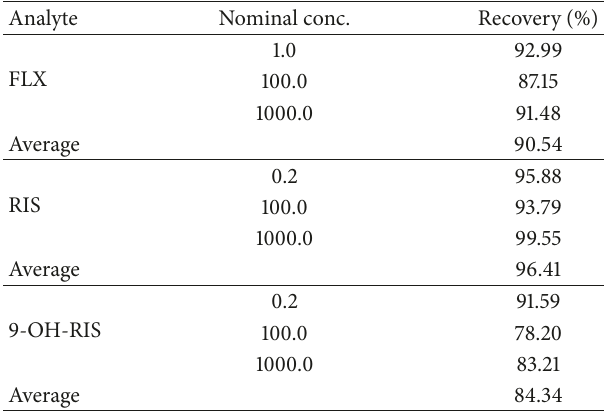
Table 3: Recovery data of FLX, RIS, and 9-OH-RIS (three QC samples each) in rat plasma (mean ± SD). Analyte Nominal conc.